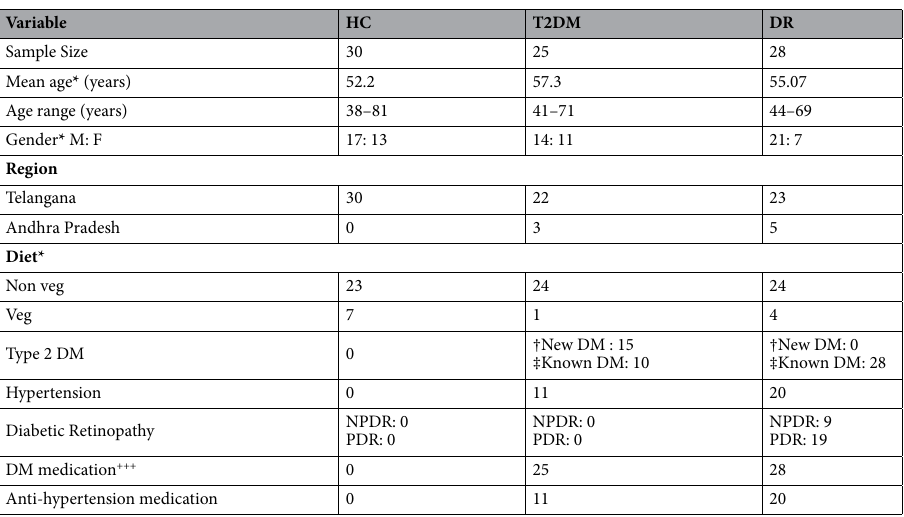
Table 1. Demographic and clinical characteristics of healthy controls (HC), type 2 diabetes mellitus (T2DM) and diabetic retinopathy (DR) individuals. * Indicates p > 0.05—not significant. † New-DMs—patients diagnosed as T2DM recently and taking anti-diabetes medication for the last 4 weeks. ‡ Known-DMs—patients with T2DM and taking anti-diabetes medication for the last 1 year. NPDR—Non-Proliferative Diabetic Retinopathy; PDR—Proliferative Diabetic Retinopathy. +++ Metformin or combinations of Metformin and/or